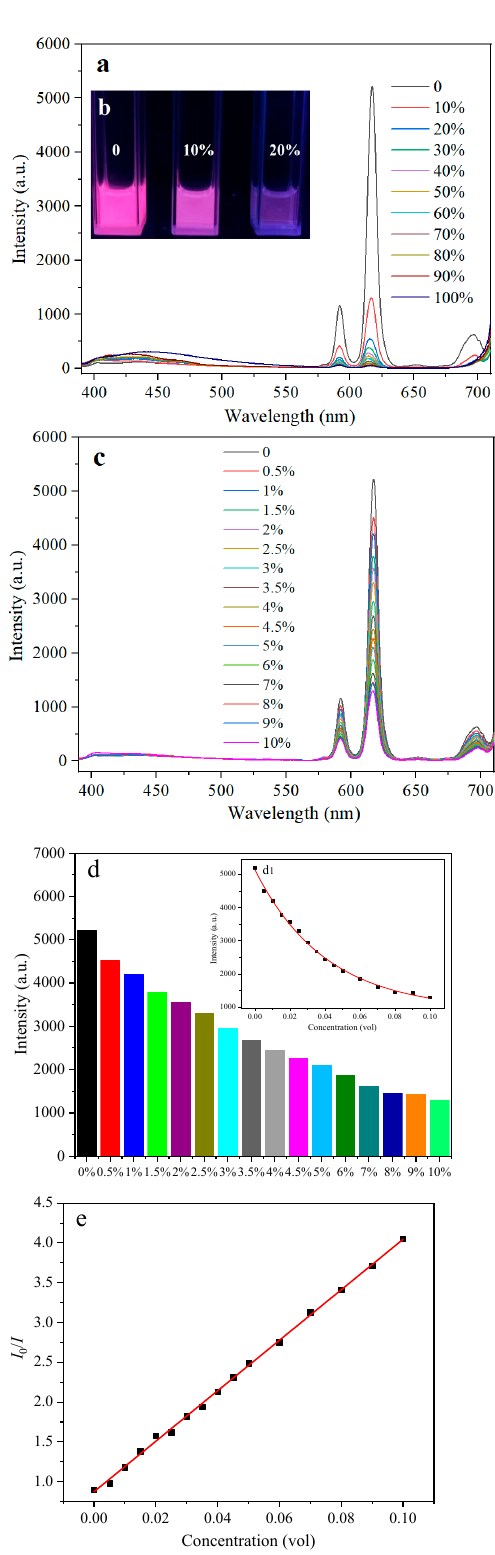
Figure 7. Fluorescence spectra of Eu-PMA-MPEG in DMF with water content from 0% to 100% ( a ); Photos of Eu-PMA-MPEG in DMF with water content of 0%, 10% and 20% under 365 nm UV light ( b ); fluorescence spectra of Eu-PMA-MPEG in DMF with trace water from 0% to 10% ( c ); fluorescent intensity I Eu at 617 nm ( d ); and the trend of I Eu vs. the water content ( d1 ); the I 0 / I vs. water content plot from 0% to 10%, with the red solid line representing the theoretical fit ( e ).